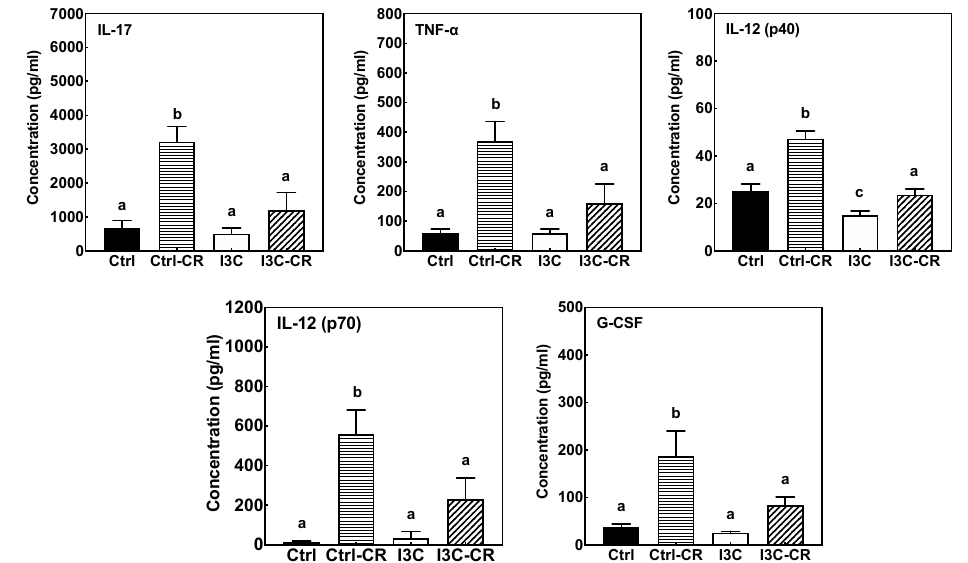
Figure 6. I3C significantly decreased Cr-induced levels of IL17, TNF- α , IL-12, and G-CSF in serum of infected mice fed control diet. Results are expressed as the mean +/ − SD (n = 8). Ctrl: control diet; Ctrl- Cr : control diet, Cr-infected; I3C: I3C diet; I3C-Cr: I3C diet, Cr-infected. Significant differences ( p < 0.05) between groups are identified by different letters.